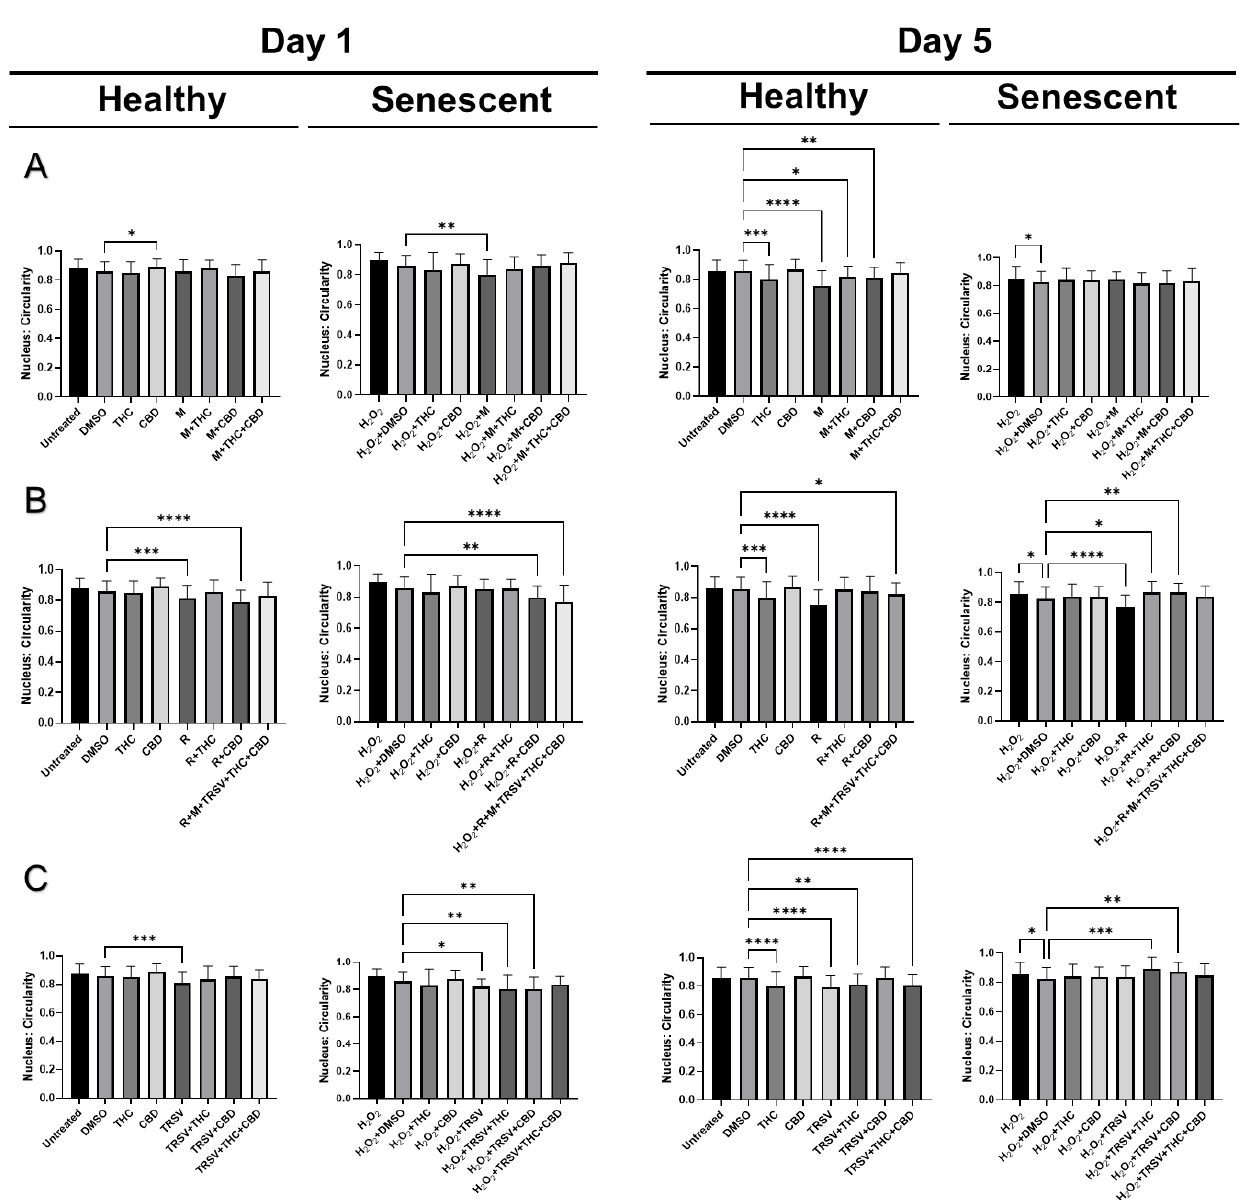
Figure 10. DAPI-stained nuclei circularity parameters of skin fibroblasts CCD-1064Sk (p.11) exposed to metformin, triacetylresveratrol, and rapamycin combined with pCBs. Nuclear parameters were observed by immunofluorescence microscopy for: healthy and senescent fibroblasts treated with ( A ) 500 µ M metformin, ( B ) 5 µ M rapamycin, or ( C ) 10 µ M triacetylresveratrol and combinations with pCBs compared to 2 µ M of THC, 2 µ M of CBD, DMSO, and untreated fibroblasts after 1 day and 5 days of exposure. Data were analyzed with a one-way ANOVA test followed by a Dunnett’s post hoc test compared to the DMSO or H 2 O 2 + DMSO control. Bars represent mean ± SD. Signifi- cance is indicated within the figures using the following scale: * p < 0.05, ** p < 0.01, *** p < 0.001, **** p < 0.0001. CBD, cannabidiol; DMSO, dimethyl sulfoxide (vehicle), M, metformin; R, rapamycin; THC, Δ -9-tetrahydrocannabinol; TRSV, triacetylresveratrol.